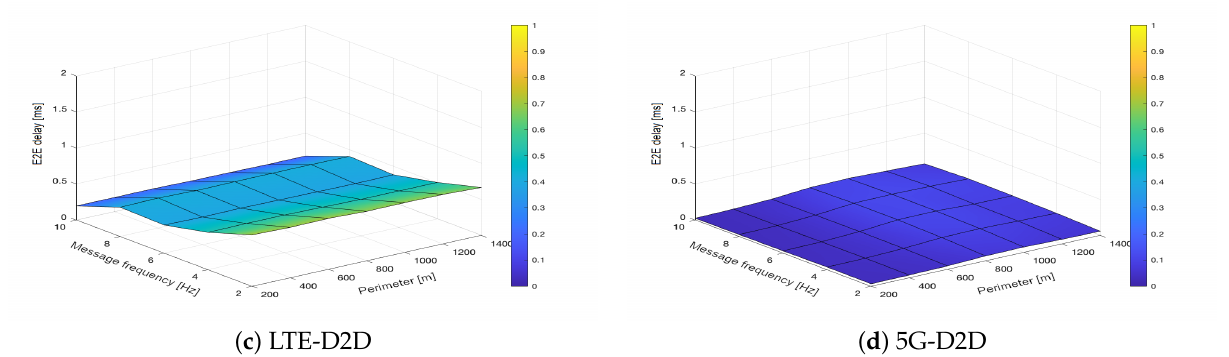
Figure 9. E2E latency simulated for all the investigated modes of the 4G-based and 5G-based C-V2X technologies and traffic intensity of 500 vehicles per hour.